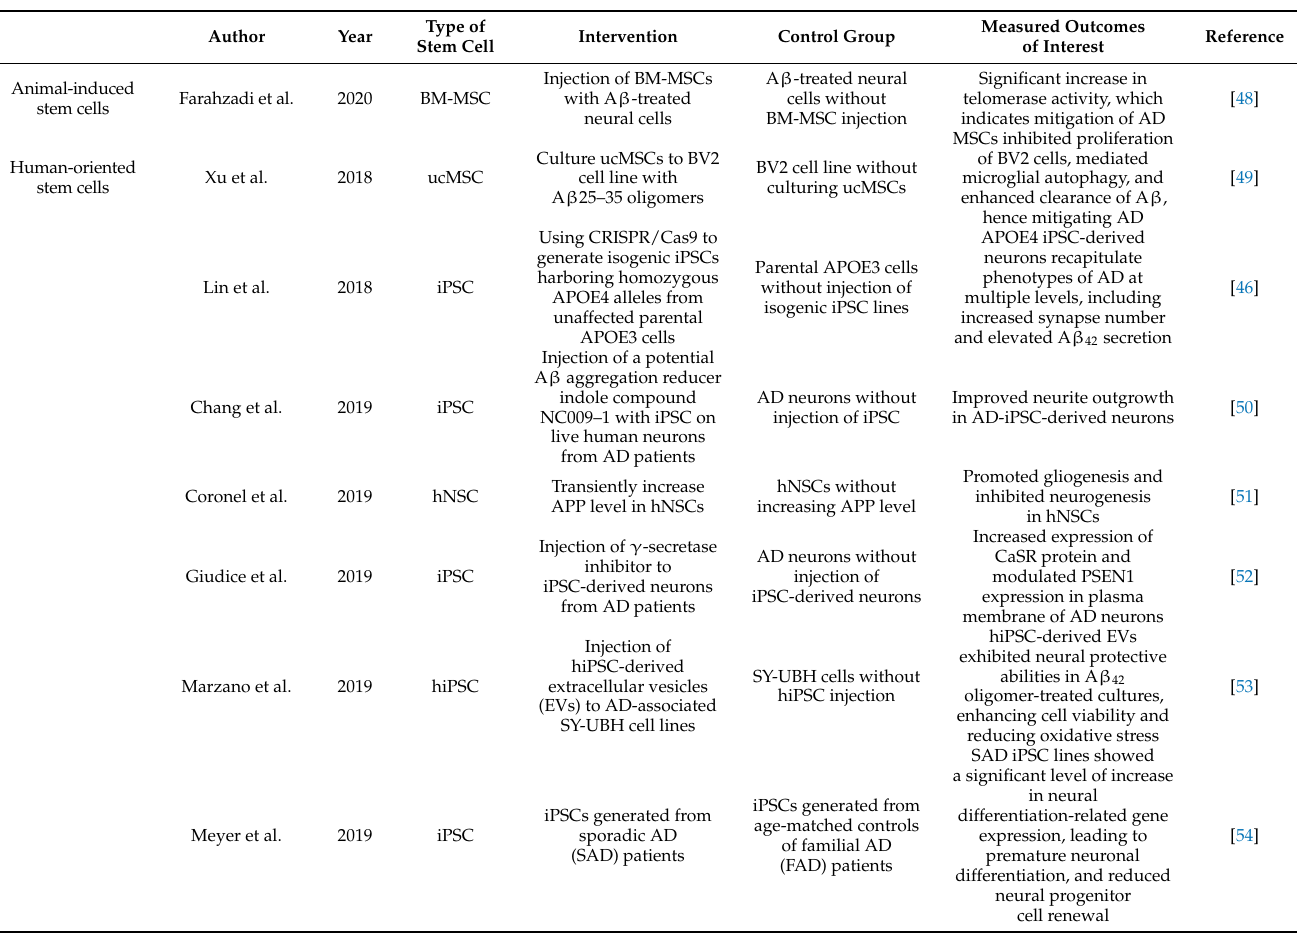
Table 1. Summary of cellular level studies on stem cell therapy for AD